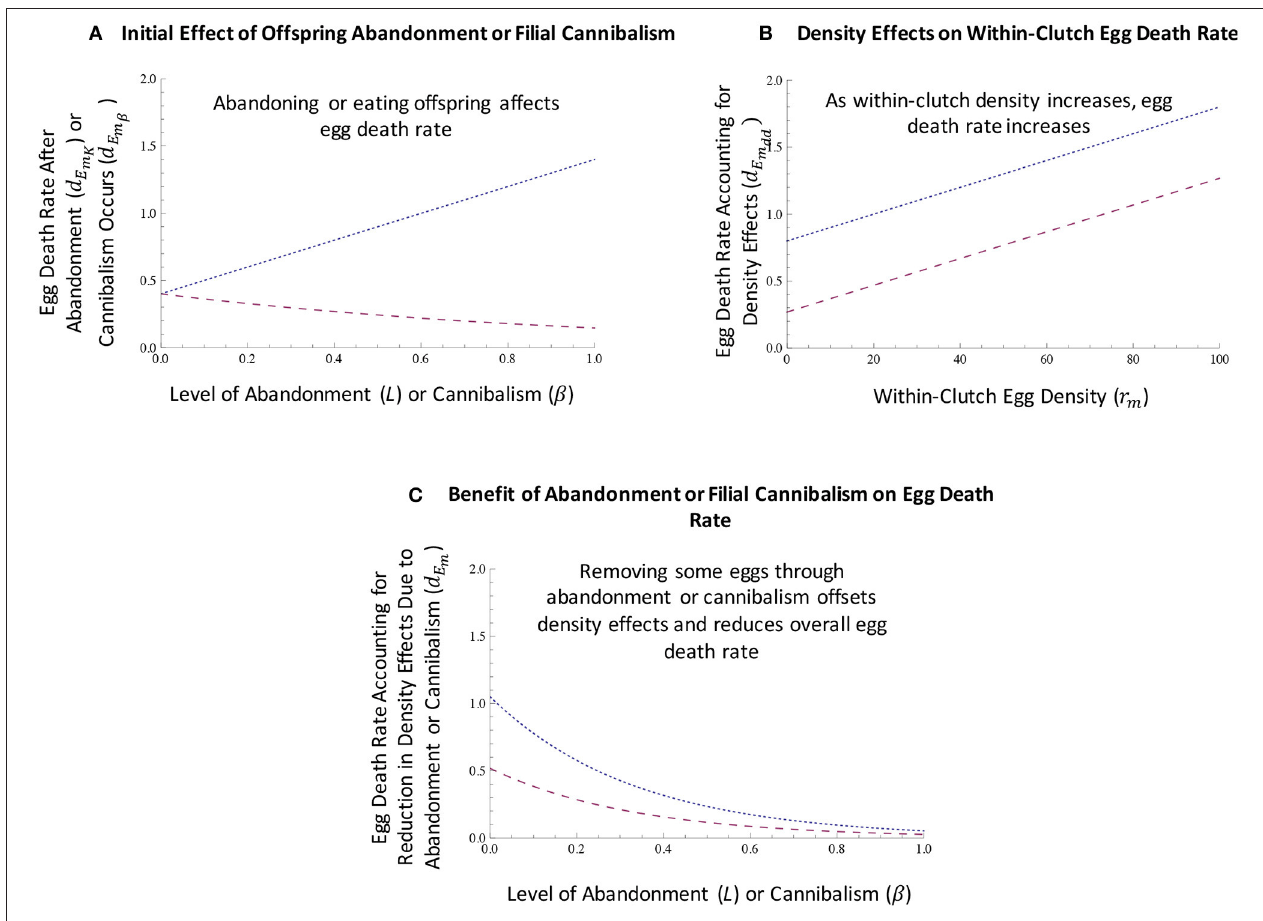
FIGURE 1 | Egg death rate of mutants is affected by costs and benefits of abandonment and cannibalism and by density effects. (A) When parents abandon or consume some of their offspring, egg death rate might initially increase because eggs are damaged or killed when they are removed from the laying or oviposition site or as they are consumed (small dashed line; abandonment scenario 1). Alternatively, abandonment might improve egg survival (medium dashed line; abandonment scenario 2), as removed eggs could have greater survival away from the laying or oviposition site when density effects exist. Specifically, in (A) we assumed that initial, baseline egg death rate ( d E ) was equal to 0.4; as parents abandon or consume their young, the egg death rate ( d E or d E ) when accounting for this m 0 mL m β abandonment ( L ) or cannibalism ( β ) increases due to the mortality caused by parents or decreases due eggs being moved to another, less dense location. (B) As offspring are assumed to be spatially clumped in the early evolution of care, we assume that there are density effects on egg death rate. Specifically, as within-clutch egg density ( r m ) increases, egg death rate ( d E ) increases. In (B) , we assumed that baseline egg death rate ( d E ) was equal to 0.4 and that the level of mdd m 0 = d E = 0.8 when abandonment and cannibalism decrease abandonment or filial cannibalism was equal to 0.4 (i.e., L = β = 0.4), which means that d E m L m β